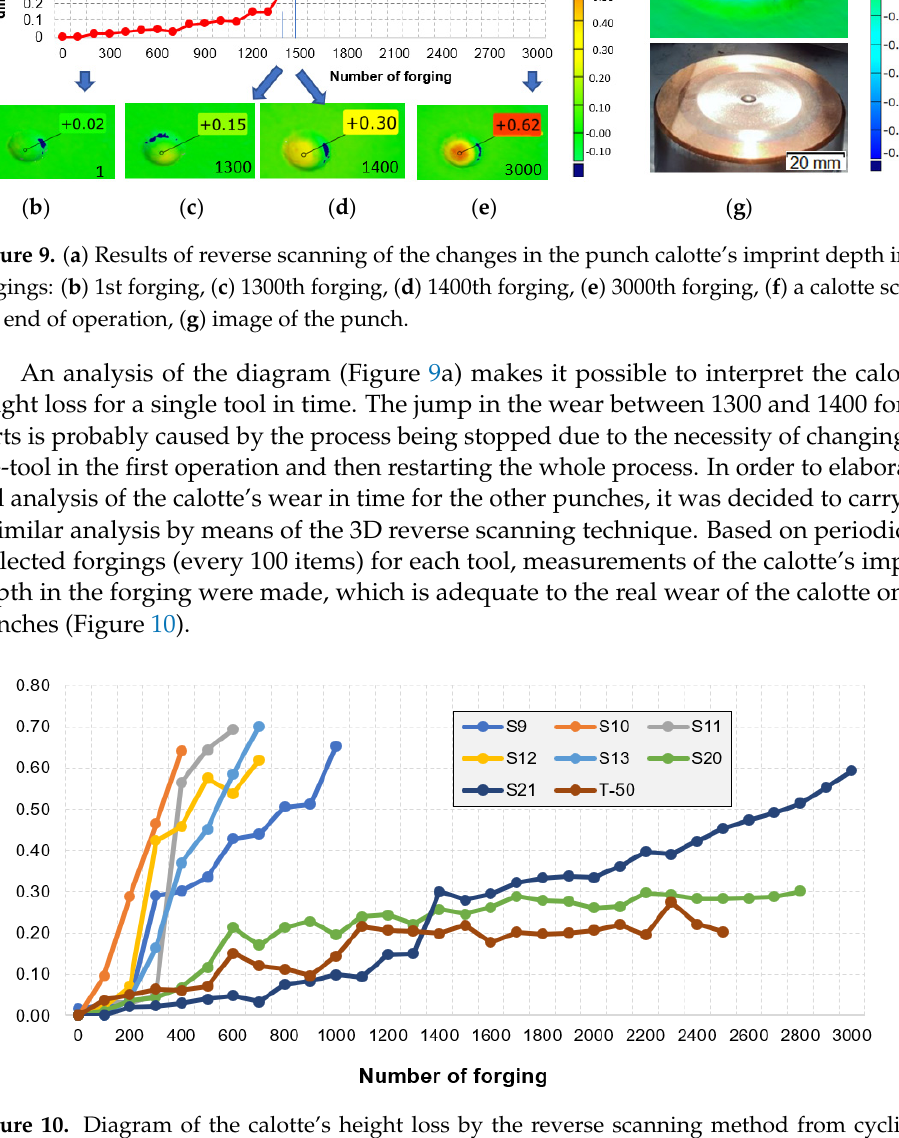
Figure 8. Results of 3D scanning of the punch calotte after the increasing number of produced forg- ings: ( a ) 62, ( b ) 420, ( c ) 600, ( d ) 620, ( e ) 700, ( f ) 1320, ( g ) 2100, ( h ) 2320, ( i ) 2660, ( j ) 3000 items.